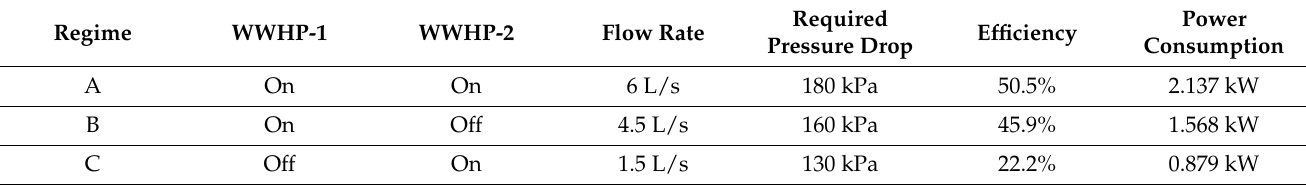
Table 3. Electricity consumption of groundwater pump for different operation